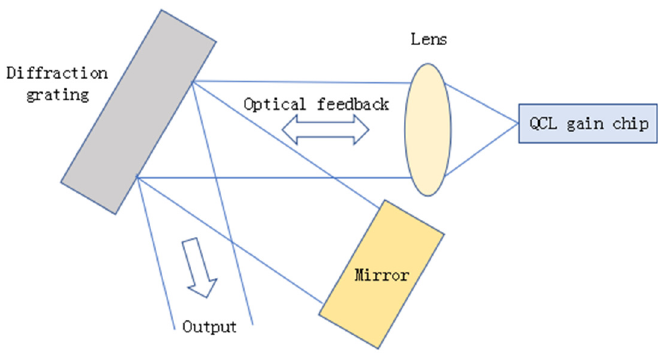
Figure 5. Littman structure of ECQCL.